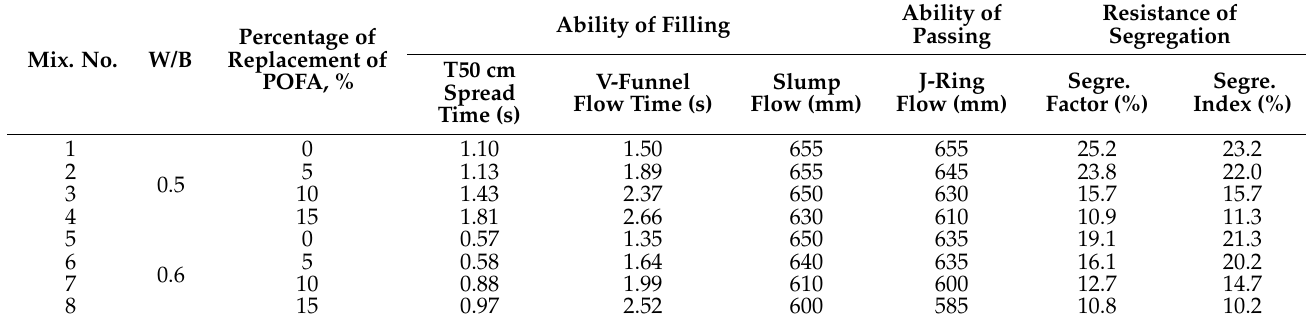
Table 9. Influence of POFA particles on segregation resistance [59].